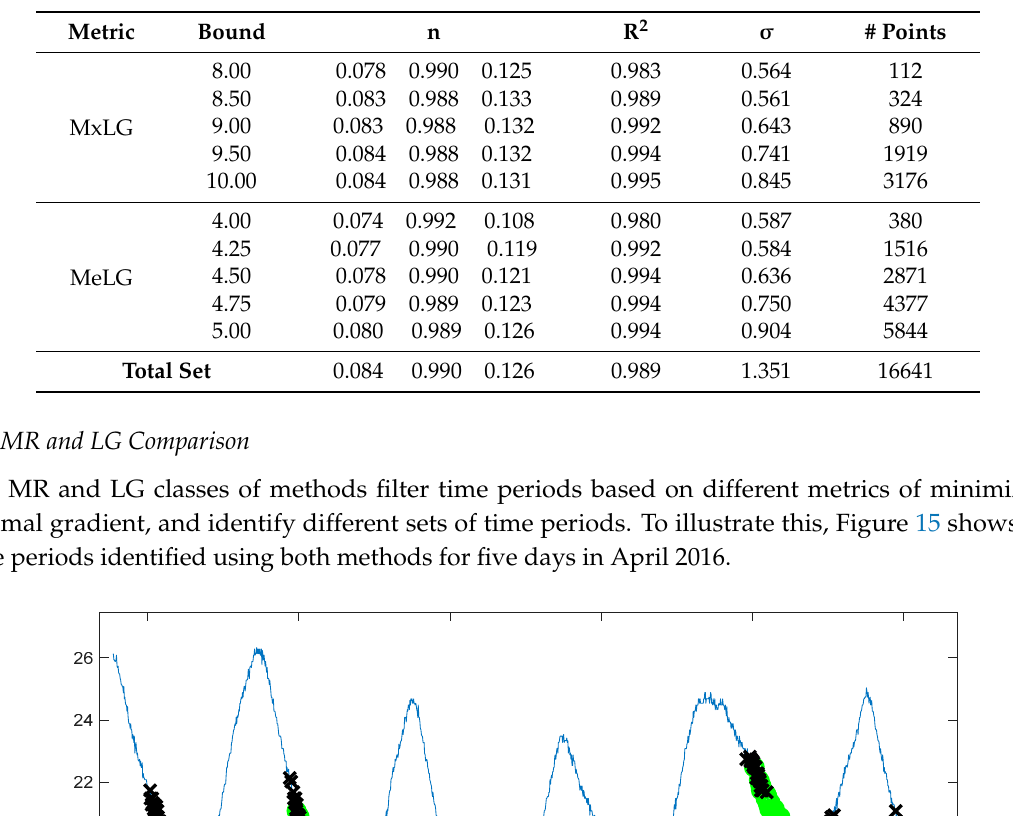
Figure 16. Summer 2010 Streicker Bridge minimal thermal gradient methods comparison.